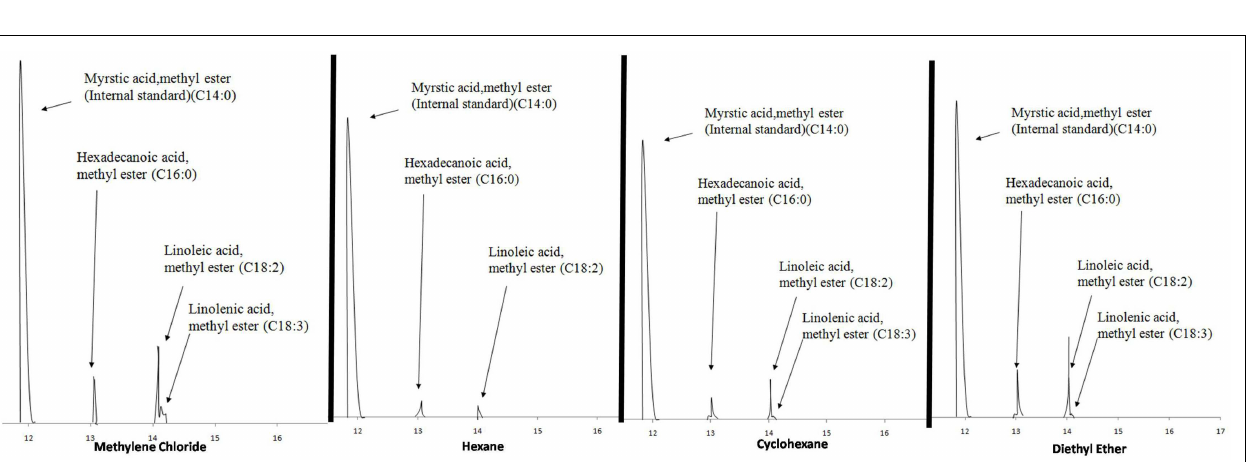
FIGURE 1 | Chromatogram of external/internal standard for response factor .